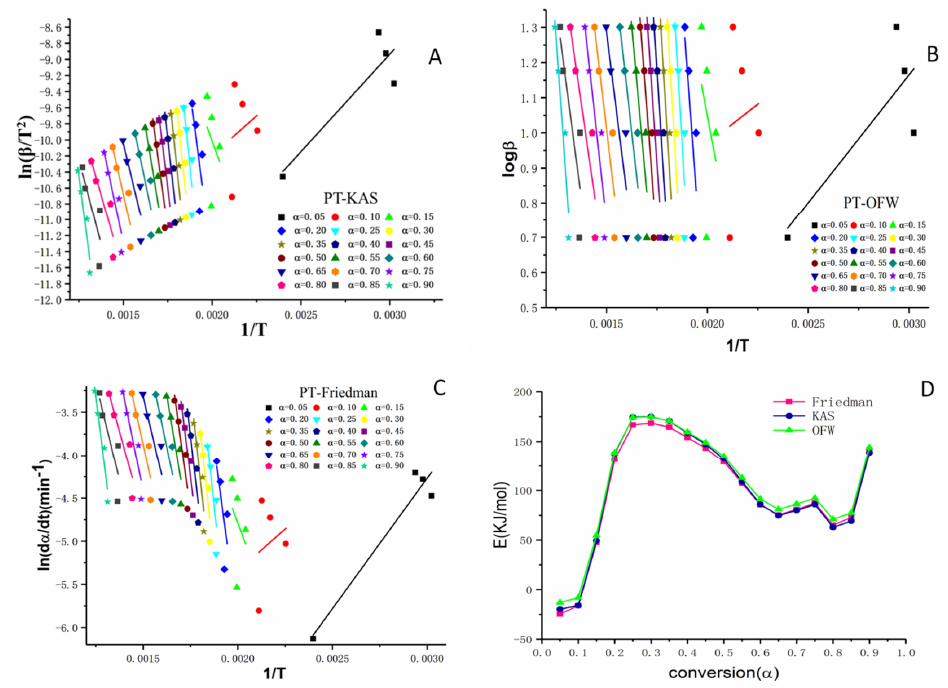
Figure 5. Estimation of activation energy using the KAS, OFW, and Friedman models for PT. Notes: Linear relationship curves ( A – C ) were made according to KAS, OFW and Friedman models at different conversion rates (from 0.05 to 0.90), respectively; ( D ) was the curve fitting charts of the three models. Table 5. Kinetic methods used in evaluating activation energy in the experiment.